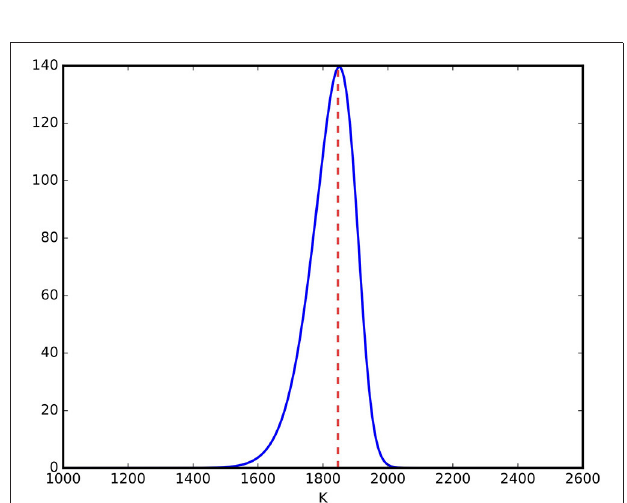
FIGURE 5 | The derivative of Heston’s call price w.r.t. the long-term mean of the volatility √ θ .